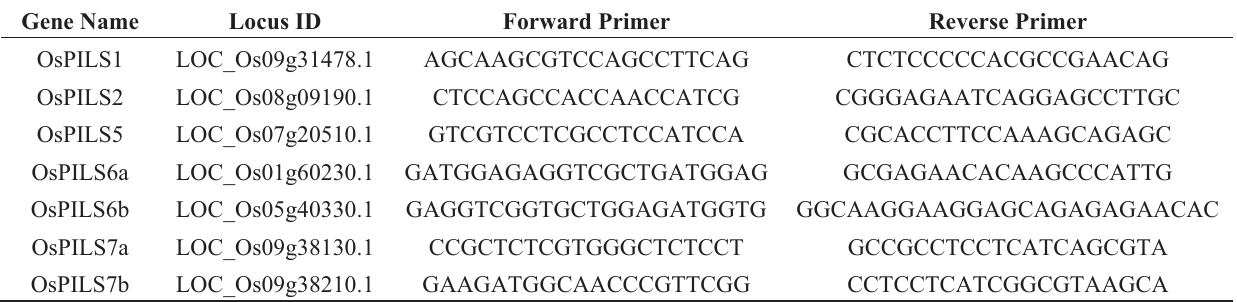
Table 1. List of primers used for analysis of relative expression of OsPILS